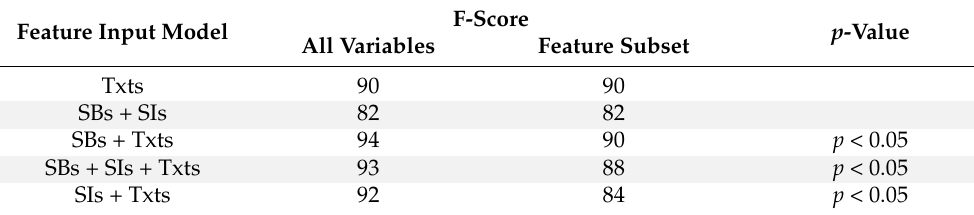
Figure 5. Feature importance scores of the 10 most important features for the image combinations. Table 5. Two sample t -tests for all variables vs feature subsets for feature input